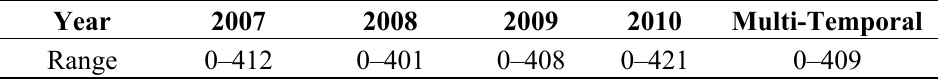
Table 2. Range of the derived GSV.